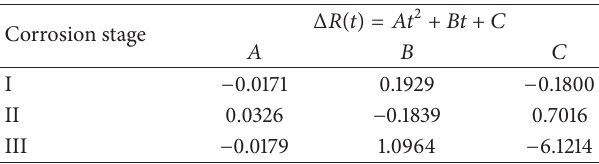
Table 1: Fitted values of 𝐴 , 𝐵 , and 𝐶 for the resistance variation